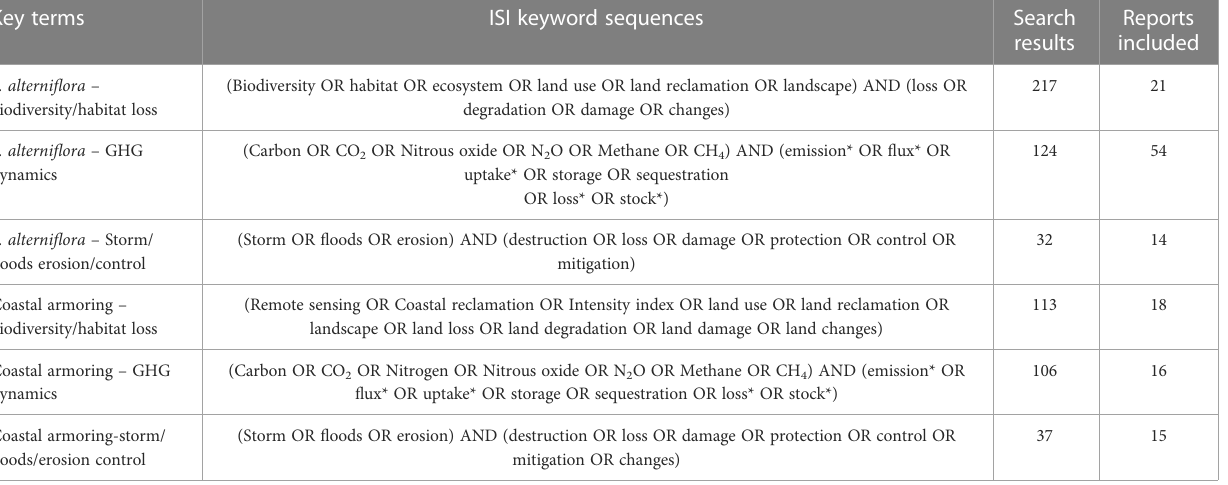
species OR alien species OR nonnative species)/(coastal armor OR coastal structures OR coastal embankments OR seawalls OR bulkheads OR dikes OR dams OR revetments) AND (ISI keyword sequences speci fi ed below).